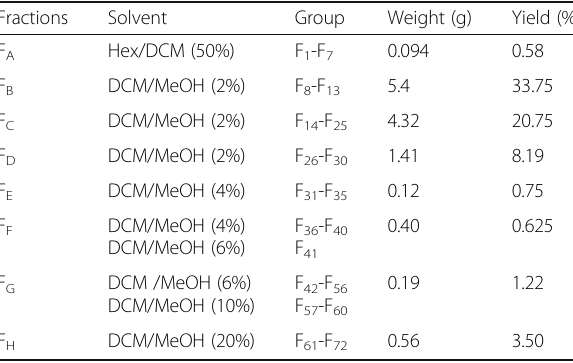
Table 1 Yield of sub-fractions of the n-butanol fraction obtained from the methanol extract of E. chlorantha stem barks